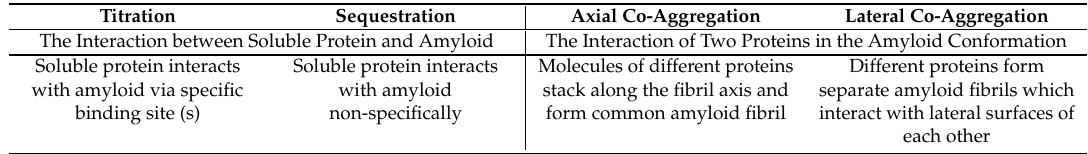
Table 2. Differences between proposed classes of protein-amyloid interactions. Titration Sequestration Axial Co-Aggregation Lateral Co-Aggregation The Interaction between Soluble Protein and Amyloid The Interaction of Two Proteins in the Amyloid Conformation Soluble protein interacts Soluble protein interacts Molecules of different proteins Different proteins form with amyloid via specific with amyloid stack along the fibril axis and separate amyloid fibrils which binding site (s) non-specifically form common amyloid fibril interact with lateral surfaces of each